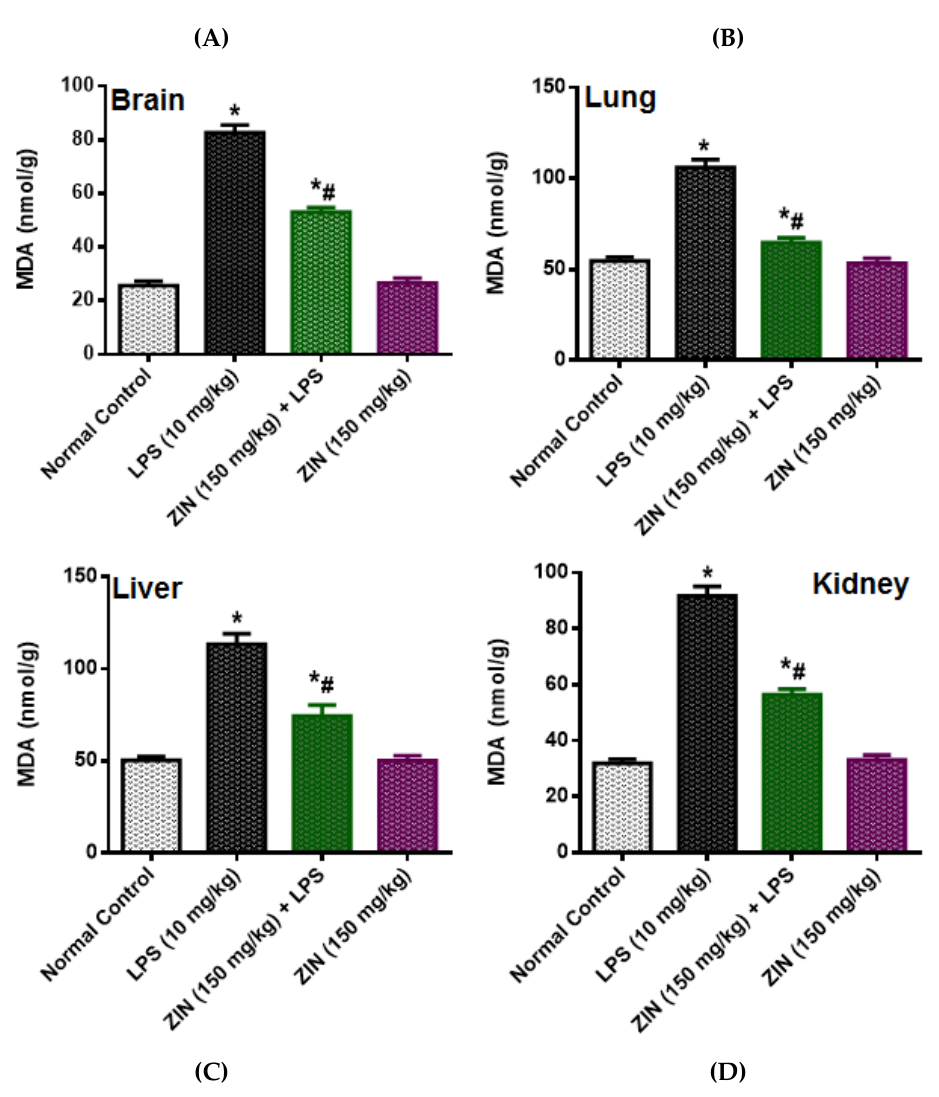
Figure 4. Effect of zingerone (ZIN) on LPS-induced oxidative stress as malondialdehyde (MDA) (nmol/kg). ( A ) Brain, ( B ) lung, ( C ) liver, and ( D ) kidney. Results are represented as mean ± SEM of six rats/group. * p < 0.05 vs. control; # p < 0.05 vs. LPS group.